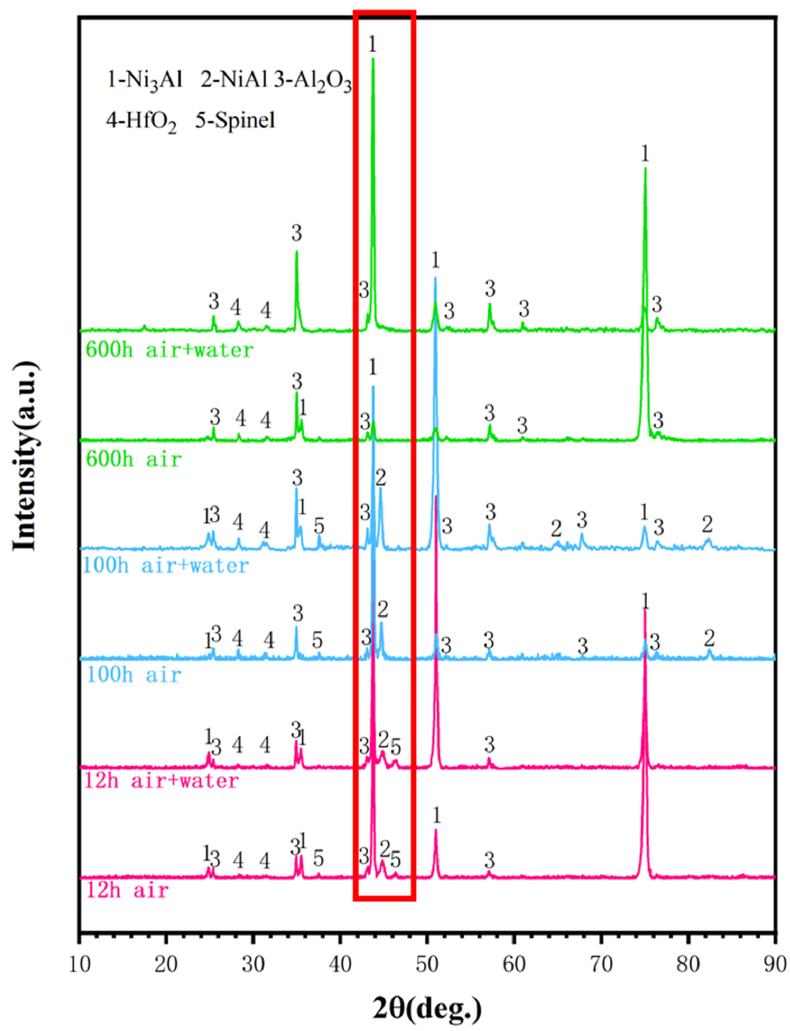
◦ C for 12, 100, and 600